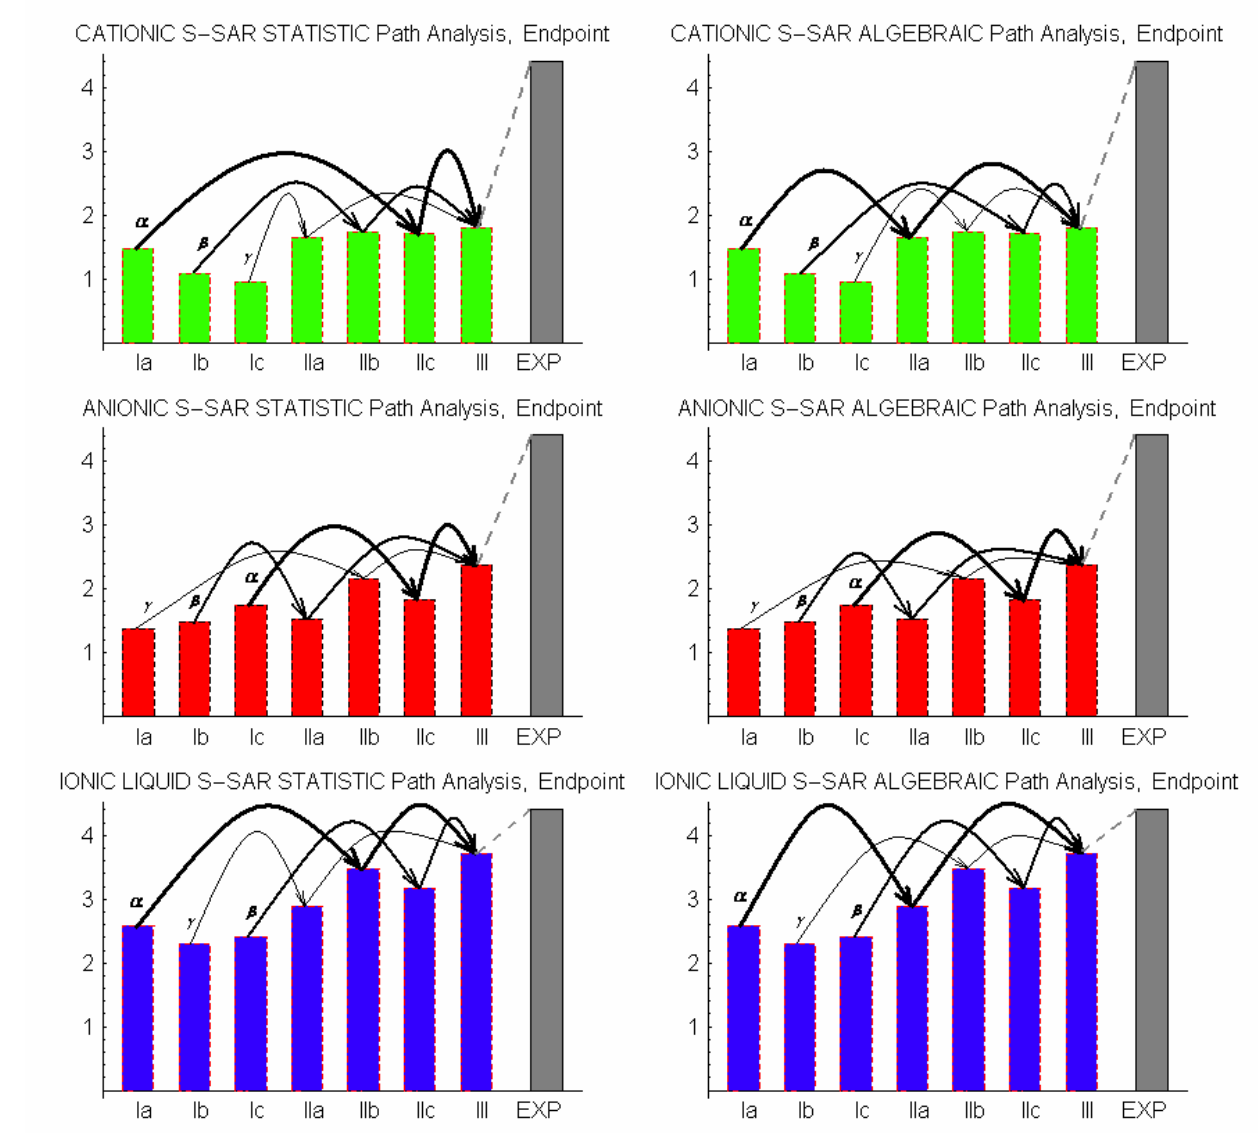
Figure 3: The spectral representation of the chemical-biological interaction paths across the S-SAR to the modeled endpoints of the Vibrio fischeri , according to the least (shortest) path rule within the spectral norm-correlation space applied on Table 7 data, for the cationic, anionic and resulted ionic liquid norms of Tables 3-5, for the statistic and algebraic versions of correlation factors, from up to down and left to right, respectively. The primary-alpha, secondary-beta and tertiary-gamma path hierarchies of Table 7 are indicated by decreasing the thickness of the connecting